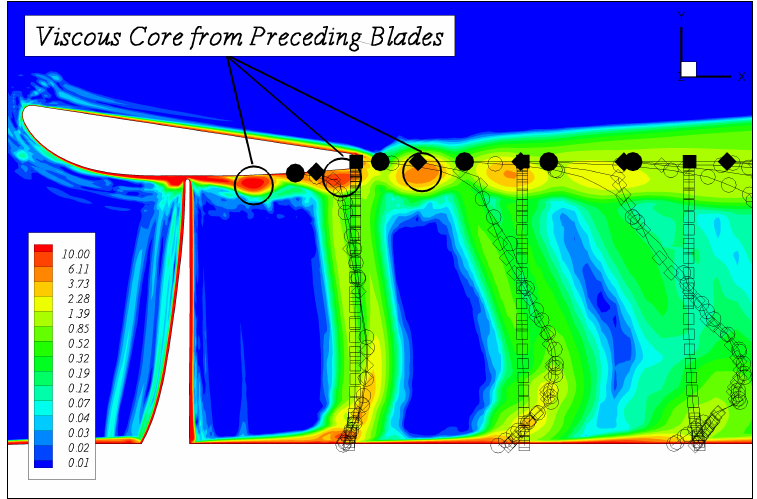
Figure 14. Wake geometry at z = 0 for J = 0.2. The contours represent the ReFRESCO total vorticity field | (cid:126) ω | / Ω . The symbols represent the PROPAN wake geometry: rigid wake model (squares), wake alignment model (diamonds) and wake alignment model with reduced gap pitch (circles). The filled symbols refer to the tip